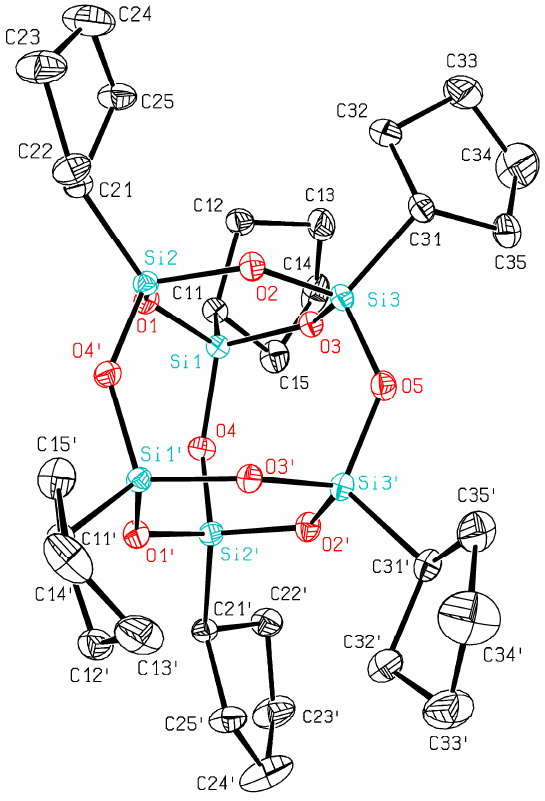
Figure 3. ORTEP plot of 3 showing the atomic numbering scheme. The probability ellipsoids are drawn at the 50% probability level. The hydrogen atoms were omitted for clarity reasons. Selected bond lengths [Å] and angles [ ◦ ]: Si1–O4 1.6269(12), Si1–O1 1.6390(11), Si1–O3 1.6430(11), Si1–C11